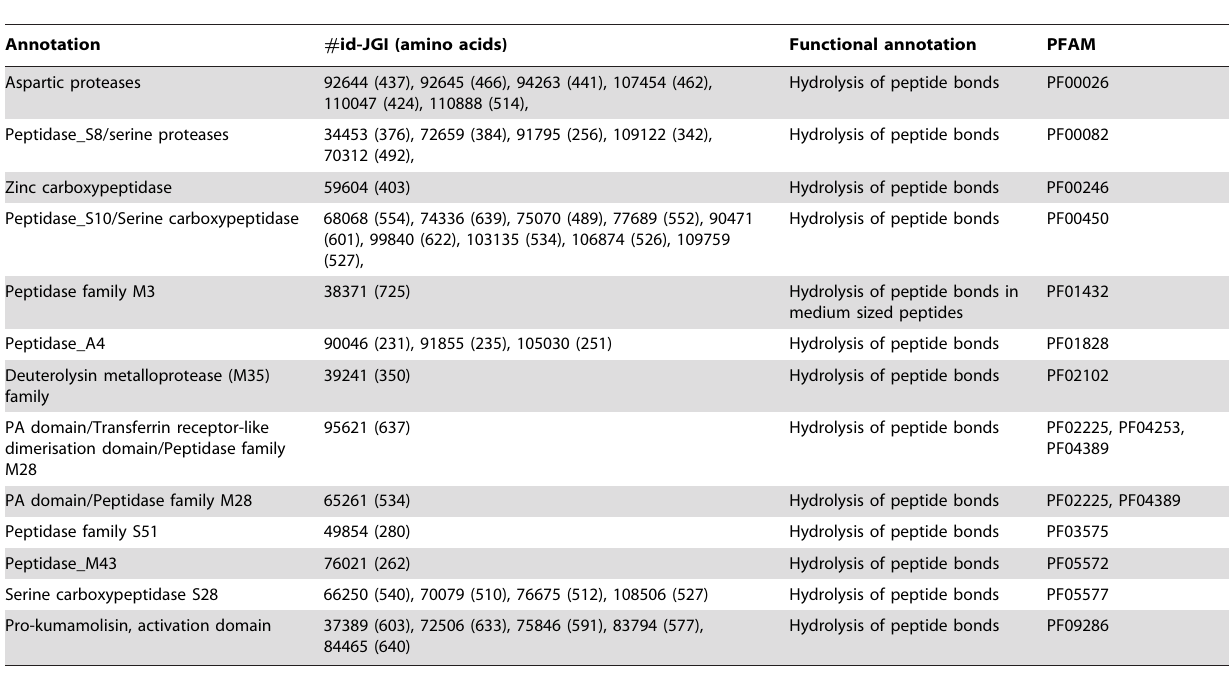
Table 3. The sub-set of M. graminicola genes that code for secreted proteins involved in the degradation of proteins.